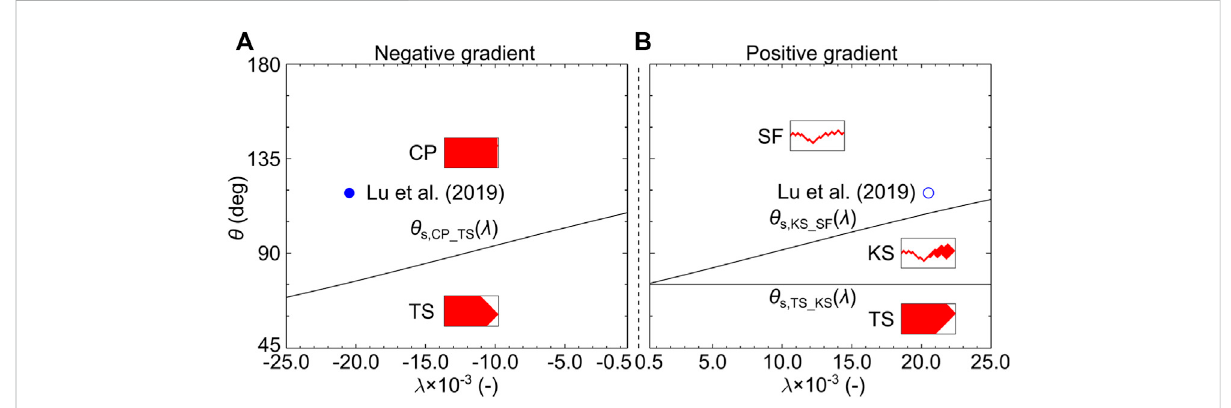
FIGURE 13 Phase diagram of displacement patterns in the square-arranged porous media with λ ranging from − 2.5 × 10 − 2 to − 5 × 10 − 4 in negative gradient porousmedia (A) andfrom5×10 − 4 to2.5×10 − 2 inpositivegradientporousmedia (B) andwith θ rangingfrom45 ° to180 ° .Theblackcurvesof θ s,CP_TS , θ θ s,TS_KS , and s,KS_SF are the boundary of CP, TS, KS, and SF in square-arranged porous media and are determined by the theoretical model (Eqs 5 Twoexperimentdatasets[31]areselectedtoevaluatetheproposedphasediagram.Thedisplacementpatternsoftheexperimentsareshownin blue circles, with the solid circle for the compact pattern (CP) and the open circle for the single- fi ngering pattern